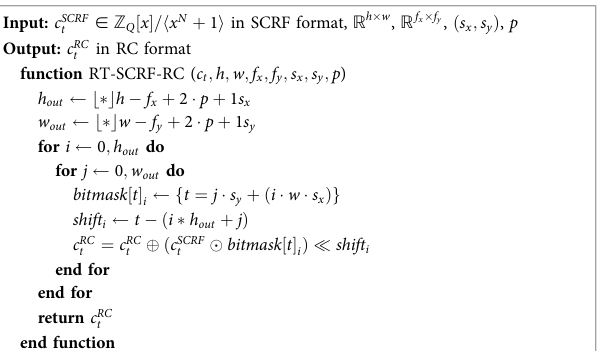
Algorithm 14 2D Padding Algorithm 13 Result Transformation SCRF to